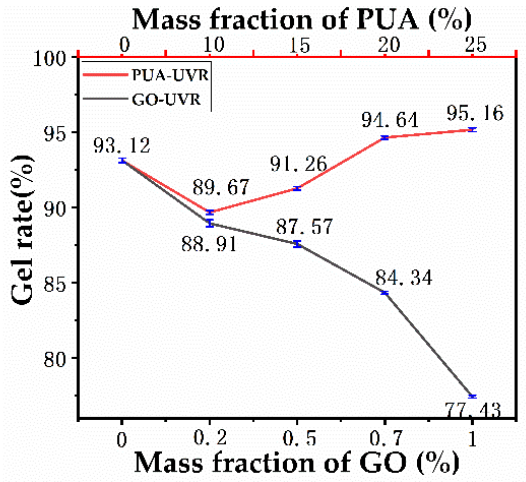
Figure 8. Gelation rate of free − radical/cationic hybrid, polyurethane acrylates modified, and graphene oxide modified photosensitive resins.